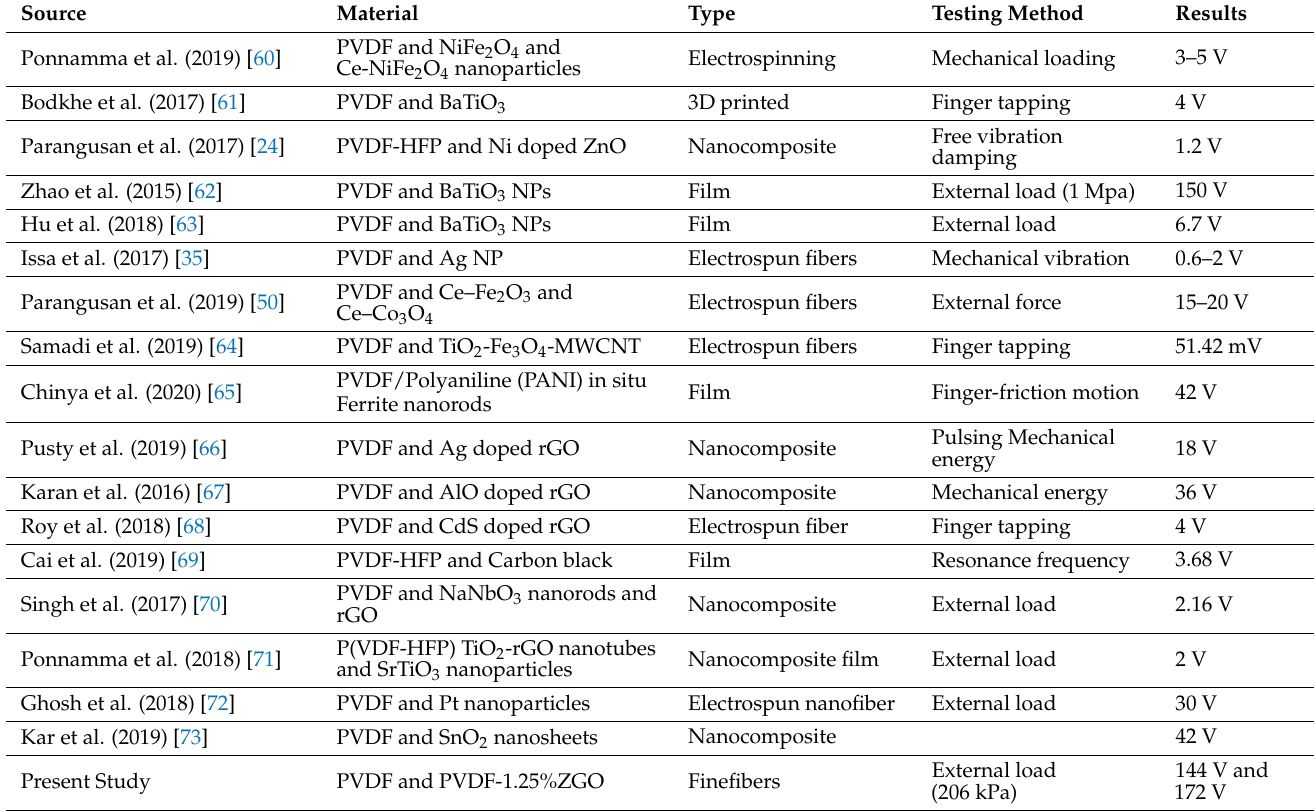
Table 1. Comparison of peak-to-peak results with similar PVDF-based composite